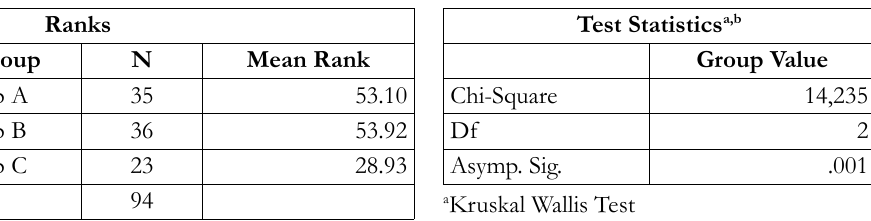
Grouping Variable: Group